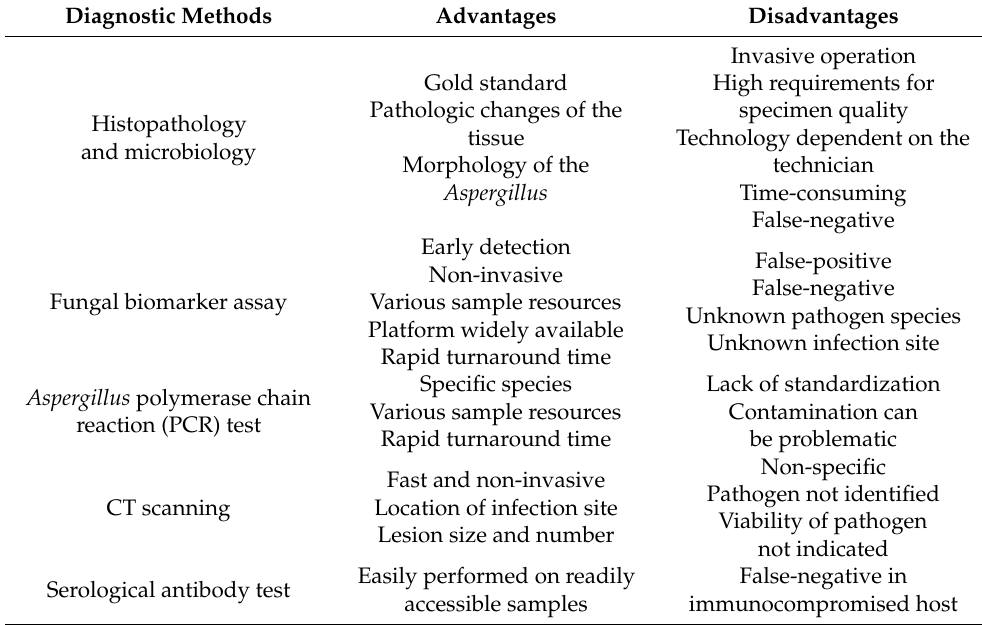
Table 1. Advantages and disadvantages of classical diagnostic methods for